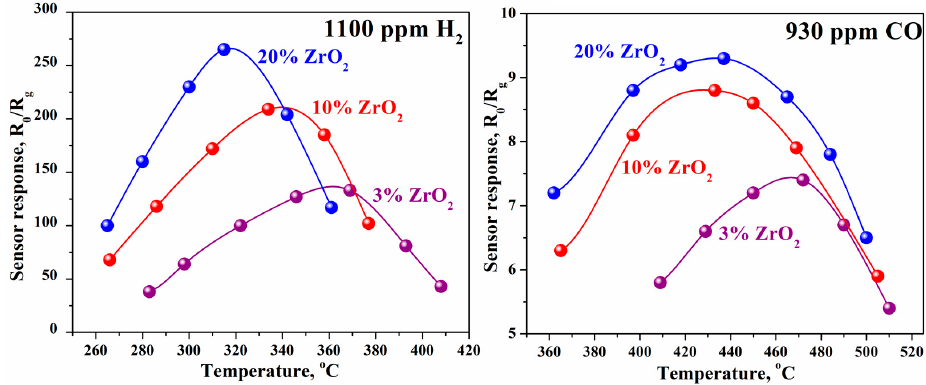
Figure 5. Temperature dependences of the sensor response of ZrO 2 –In 2 O 3 composites at detection of 1100 ppm H 2 and 930 ppm CO.